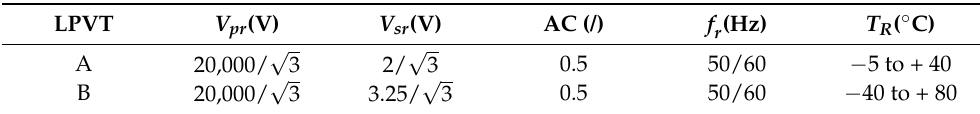
Table 2. Main characteristics of the two passive capacitive low-power voltage transformers (LPVTs) under test.